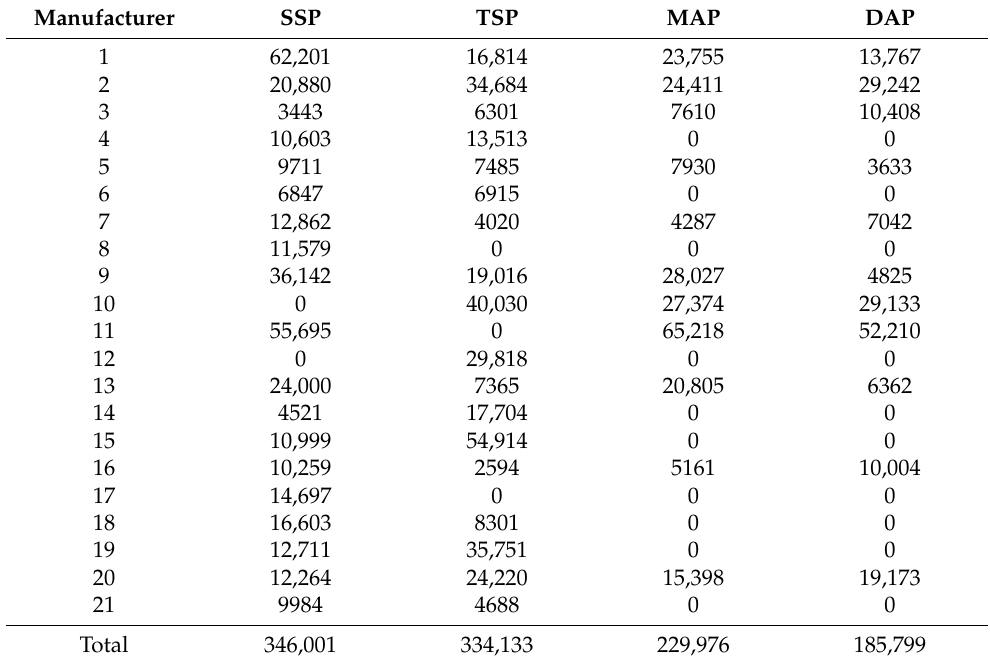
Table 10. Total production of the P-fertilizers by each manufacturer (ton).